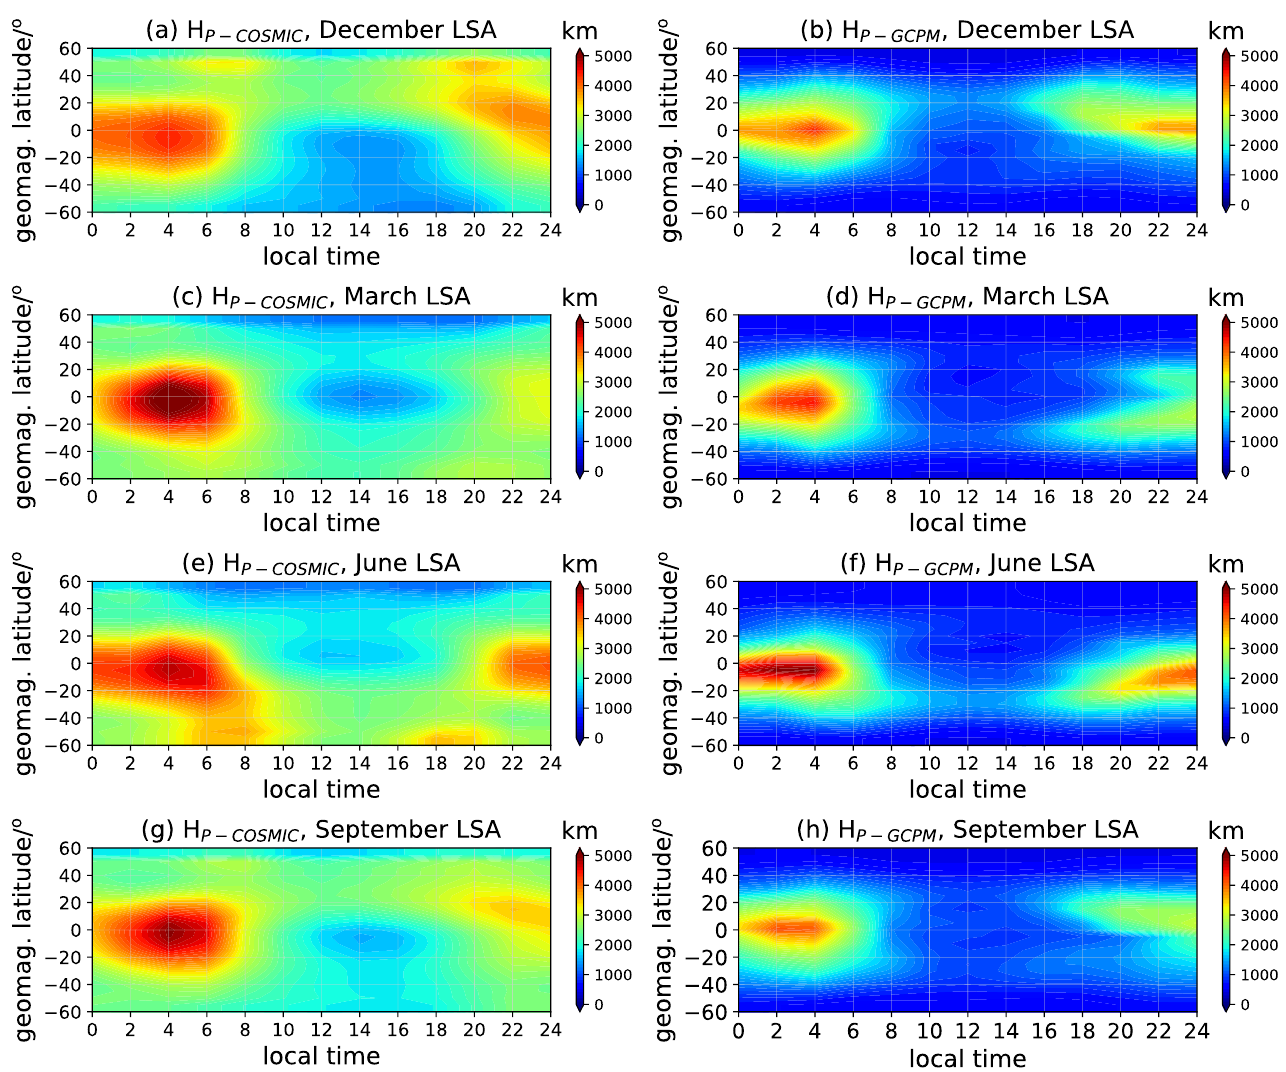
Figure 3. The distribution of the COSMIC and GCPM retrieved H P (represented by ‘ H P _ COSMIC ’ and ‘ H P _ GCPM ’) along with the local time, geomagnetic latitude, and season in the LSA year; panels ( a , c , e , g ) are for H P _ COSMIC , panels ( b , d , f , h ) are for H P _ GCPM .